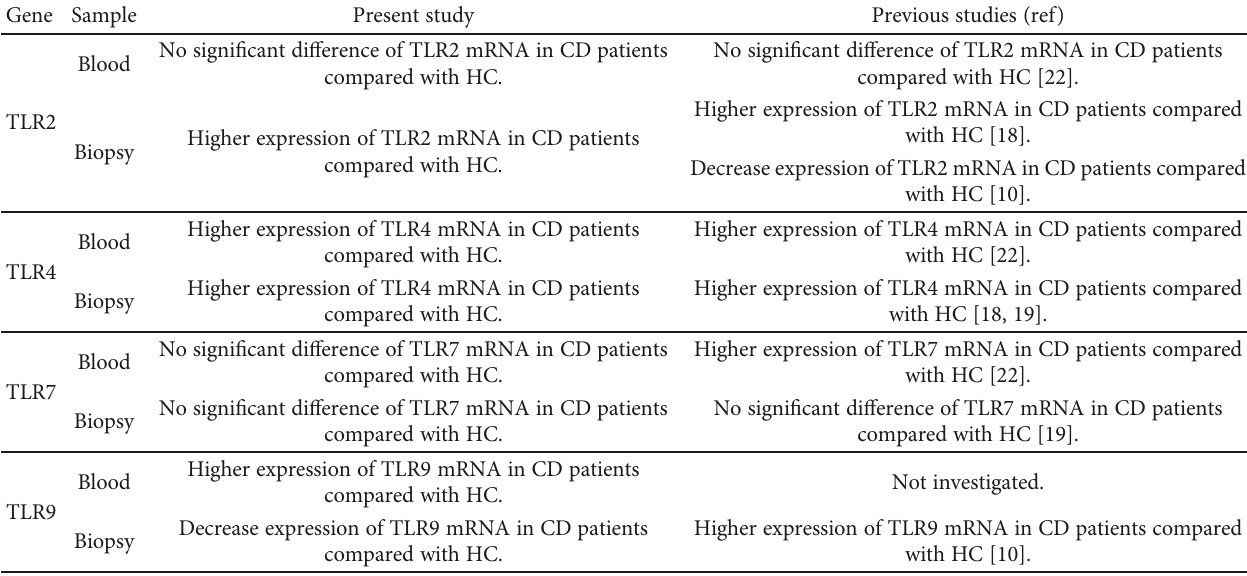
Table 2: Comparison of TLR gene expression between the present and previous studies in blood and biopsy specimens of patients with active CD. Gene Sample Present